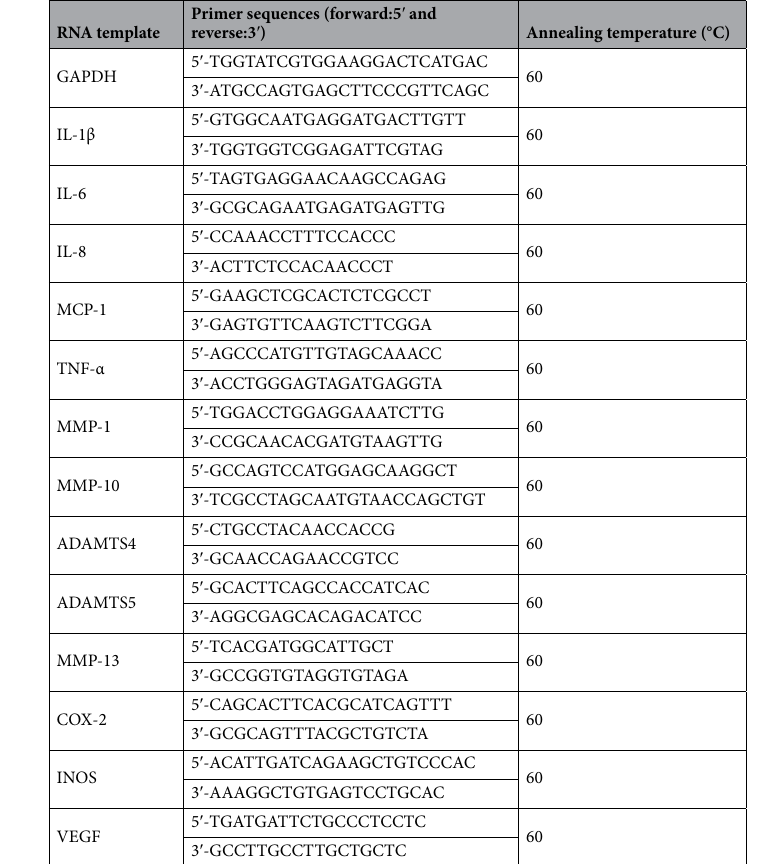
Table 1. List of primers used in Real-Time